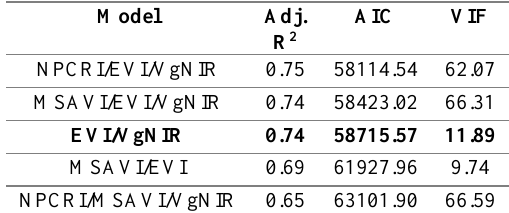
Table 4. Top five OLS models based on Adjusted R 2 and AIC which used combinations of only spectral indices as explanatory variable (selected models for Regression-Kriging are highlighted in bold text)